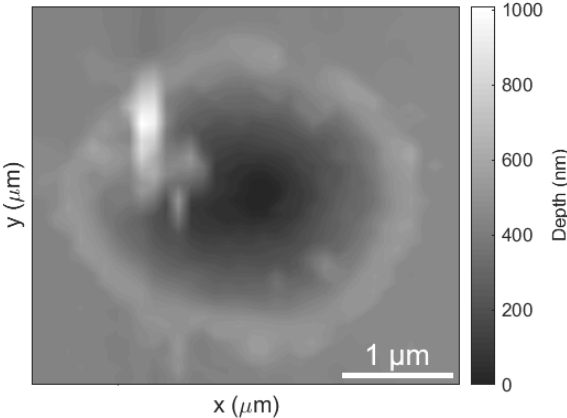
Figure 1. 2D AFM crater image with a depth profile.